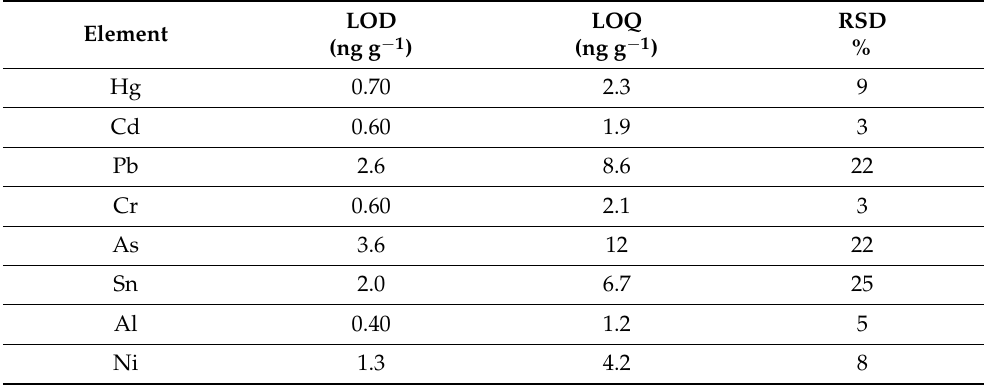
Table 4. Limit of detection (LOD), limit of quantification (LOQ) and precision (% RSD) of the investigated